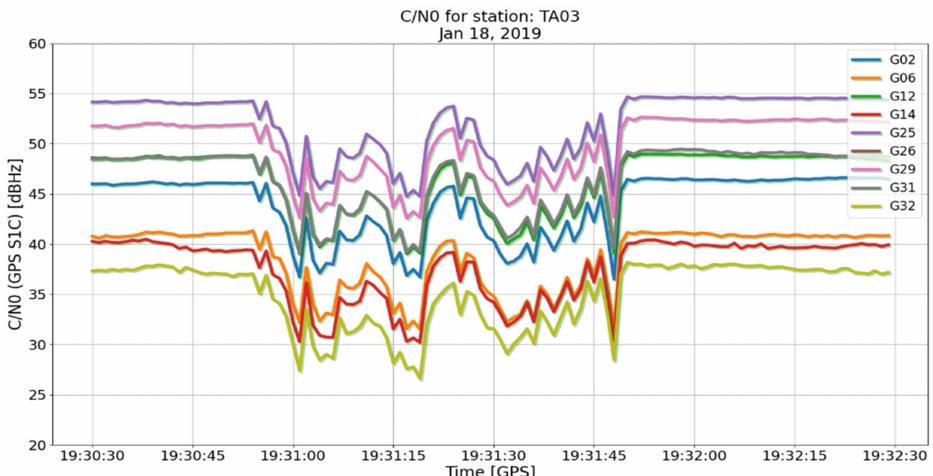
Figure 3. C/N 0 values for GPS L1 observations during the last jamming incident registered at TA03 on 18 January